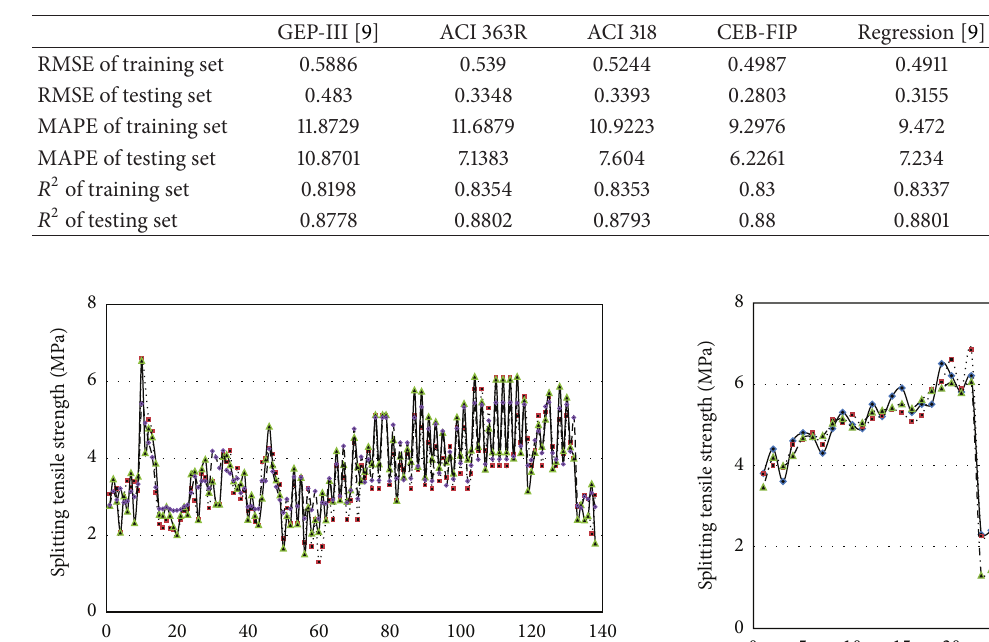
from 100 × 200mm cylinder 𝑓 𝑐 . spt